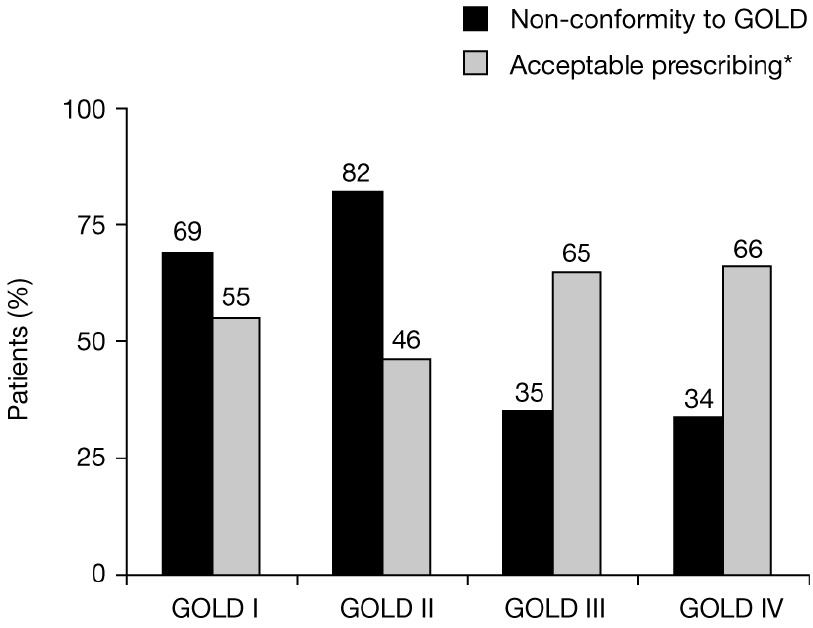
Figure 1 Non-conformity to GOLD